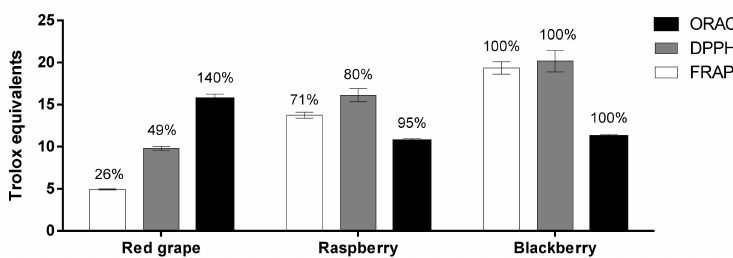
Figure 2. Antioxidant capacity of hydroalcoholic extracts from commercial Red Globe grape, raspberry and blackberry. Values were expressed as mean [ n ≥ 9; mg TE / gDW (DPPH, FRAP) or 1 × 10 1 µ mol TE / g DW (ORAC)]; percentages above bars indicate di ff erences between samples considering blackberry antioxidant titers as